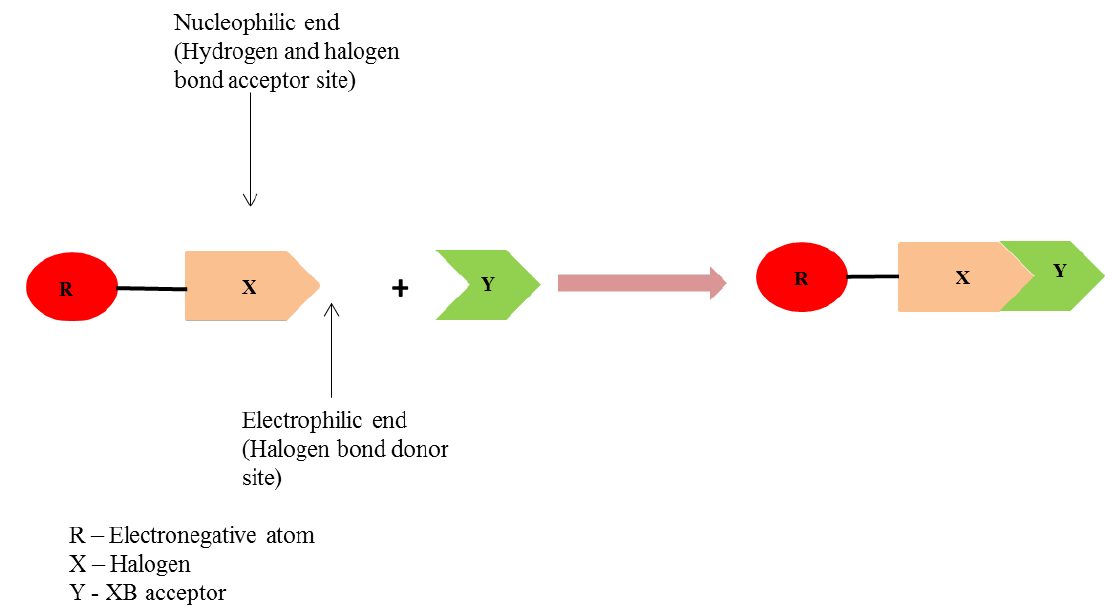
Figure 15. Schematic representation of halogen bonding between two molecules [241].